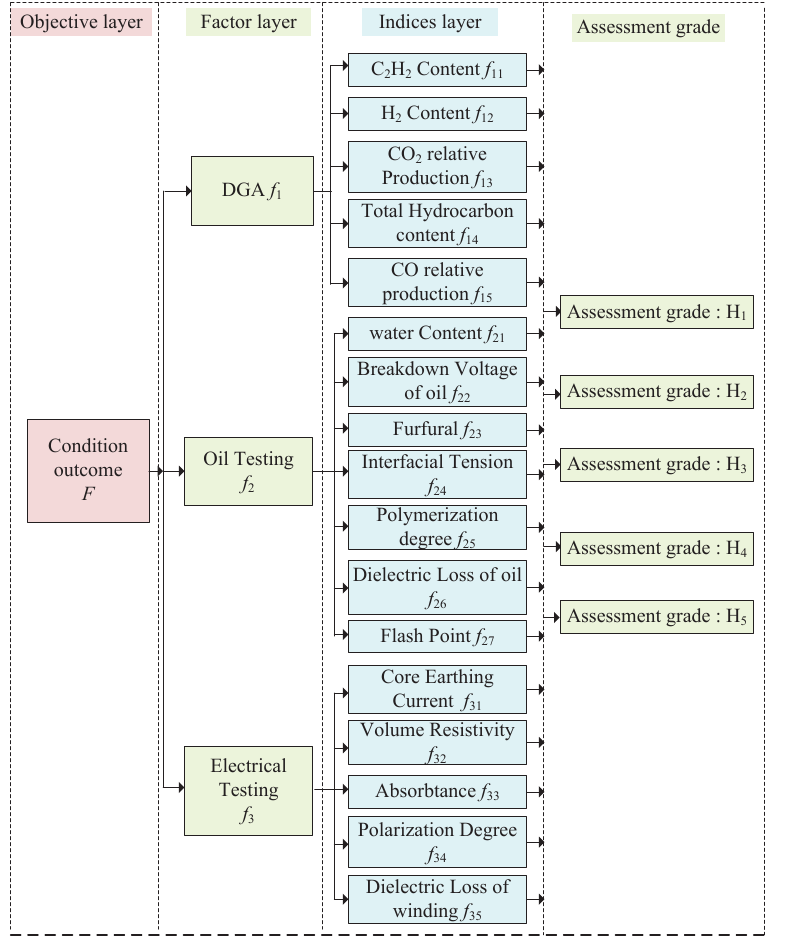
Figure 1. Condition information framework of the power transformer. Table 1. Assessment grades’ relation to the